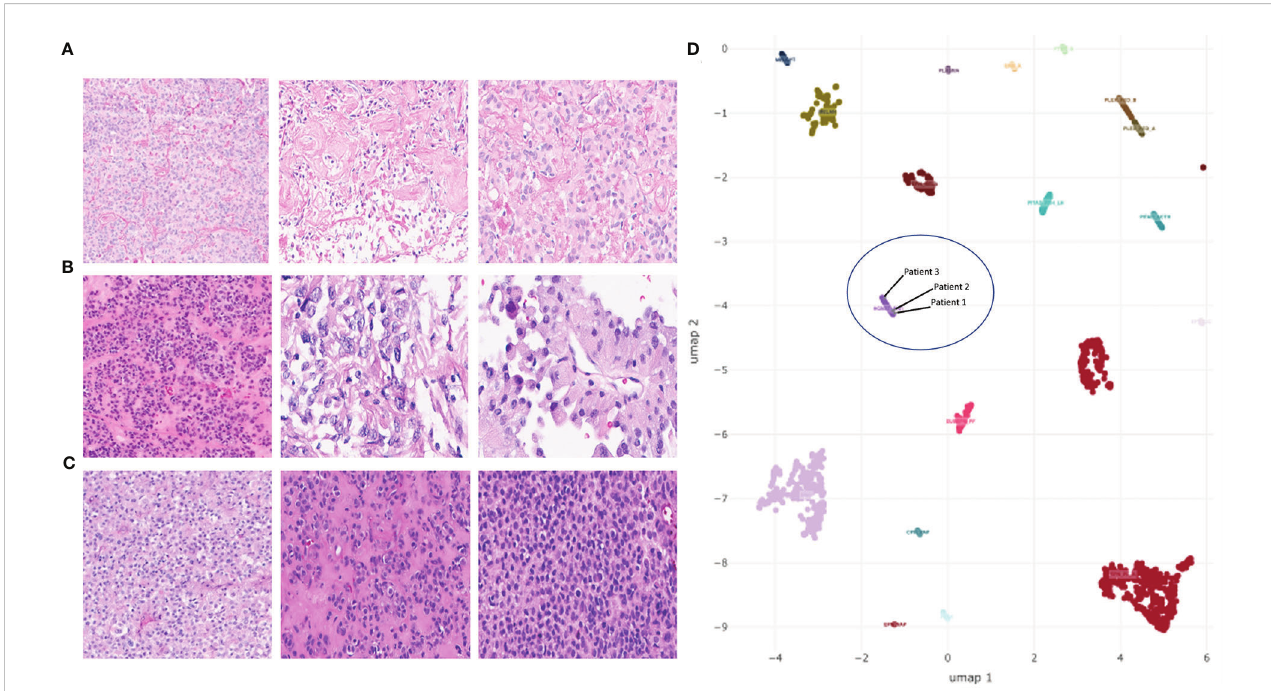
FIGURE 2 H&E-stained sections of tumors and UMAP embedding of DNA methylation array data for select tumor types. (A – C) H&E-stained sections showing the range of histologic characteristics of astroblastoma (wide-tapered perivascular pseudorosettes and prominent hyalinization) for patient 1 (A) , patient 2 (B) , and patient 3 (C) . (D) UMAP embedding of MN1- altered astroblastoma samples (HGNET-MN1), embedded among select groups of CNS tumors. Three samples from MN1 -fused patients discussed in this study are included in a blue circle.